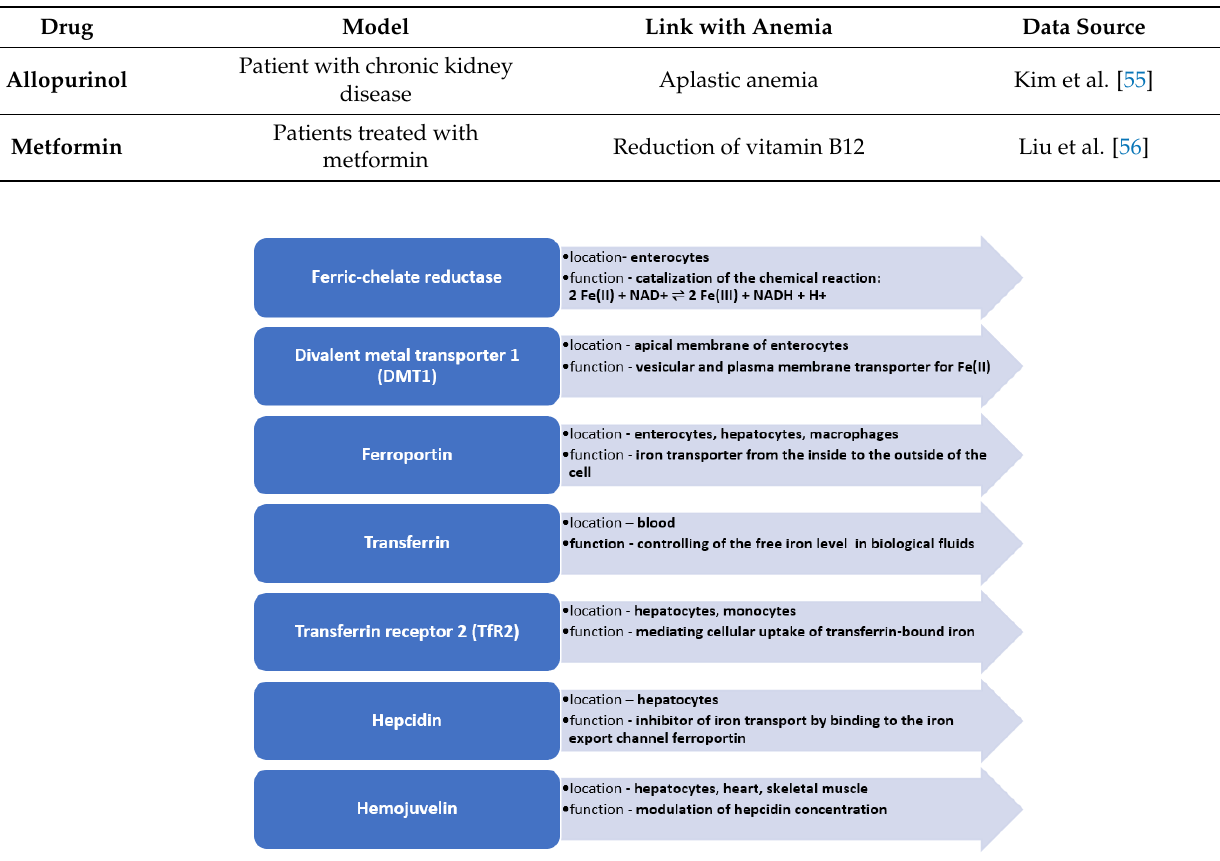
Figure 1. Key enzymes in iron metabolism in human body.